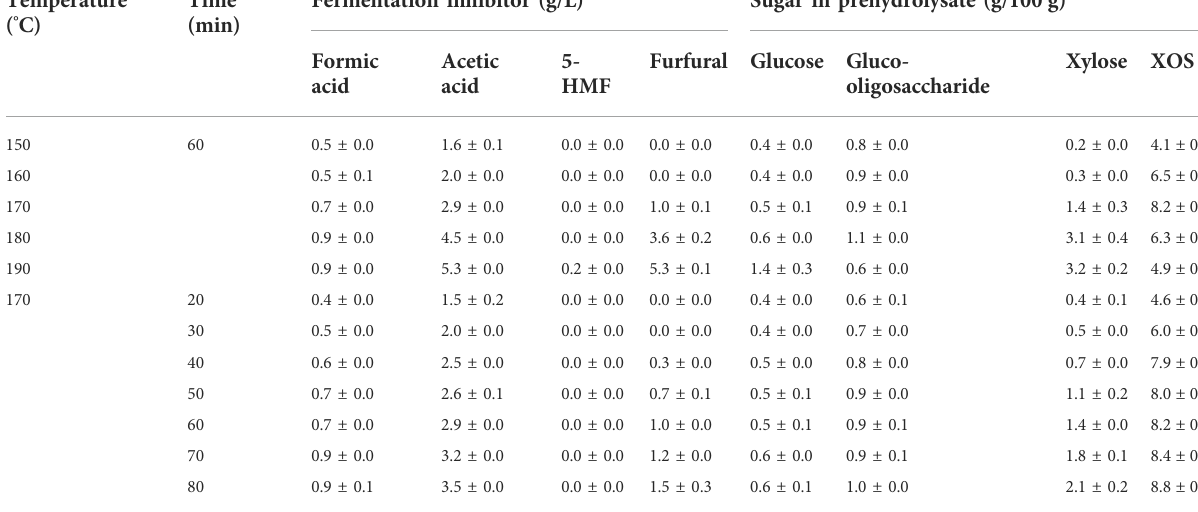
TABLE 2 Sugars and byproducts in prehydrolysates of BSS after autohydrolysis. Temperature ( °